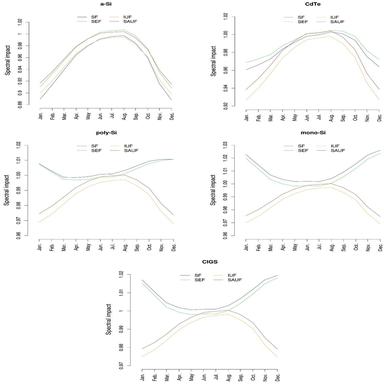
Monthly behaviour of the four analysed indexes for the five PV materials considered in Granada.